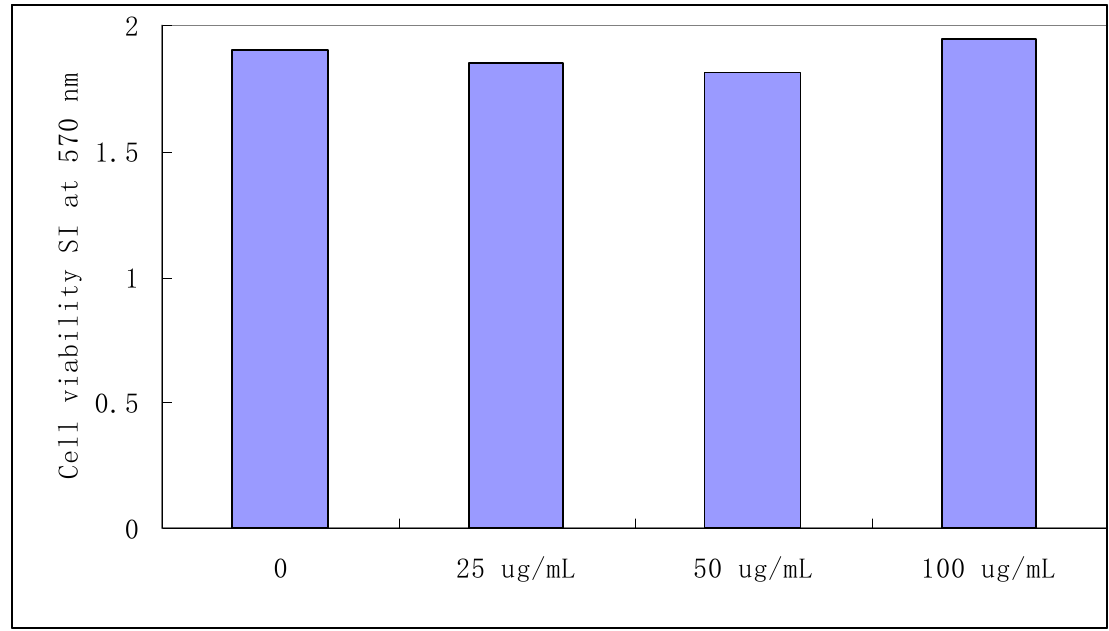
Figure 2. Effect of 8-gingerol on the viability of splenocytes.